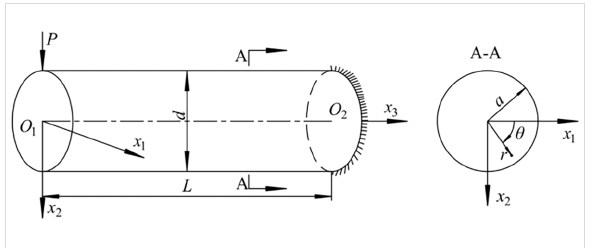
Figure 1: A circular ZNW cantilever exposed to a force P at the free